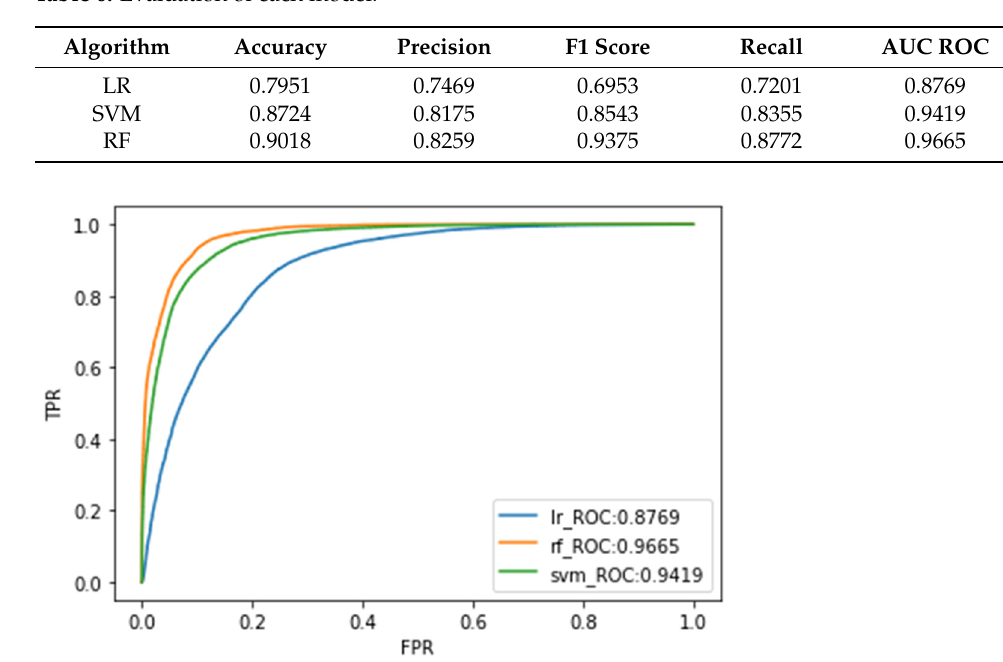
Table 6. Evaluation of each model.